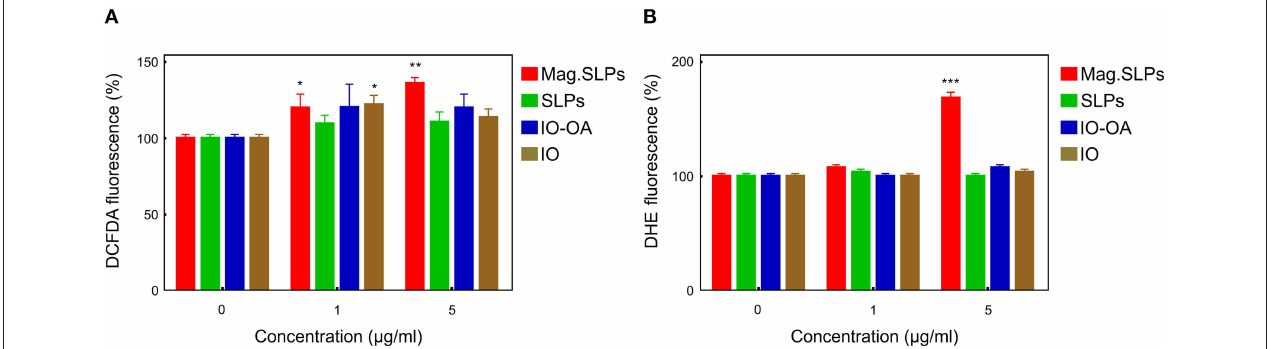
FIGURE 6 | Flow cytometric analysis of ROS level in Jurkat cells treated with mag.SLPs, SLPs, IO-OA, and IO for 24h. (A) Cell staining with 2 ′ ,7 ′ -dichlorofluorescein diacetate (DCFDA; H